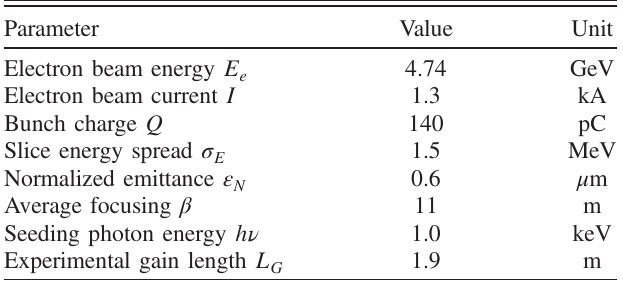
TABLE III. Experimental parameters of the soft X-ray self- seeding at the LCLS.